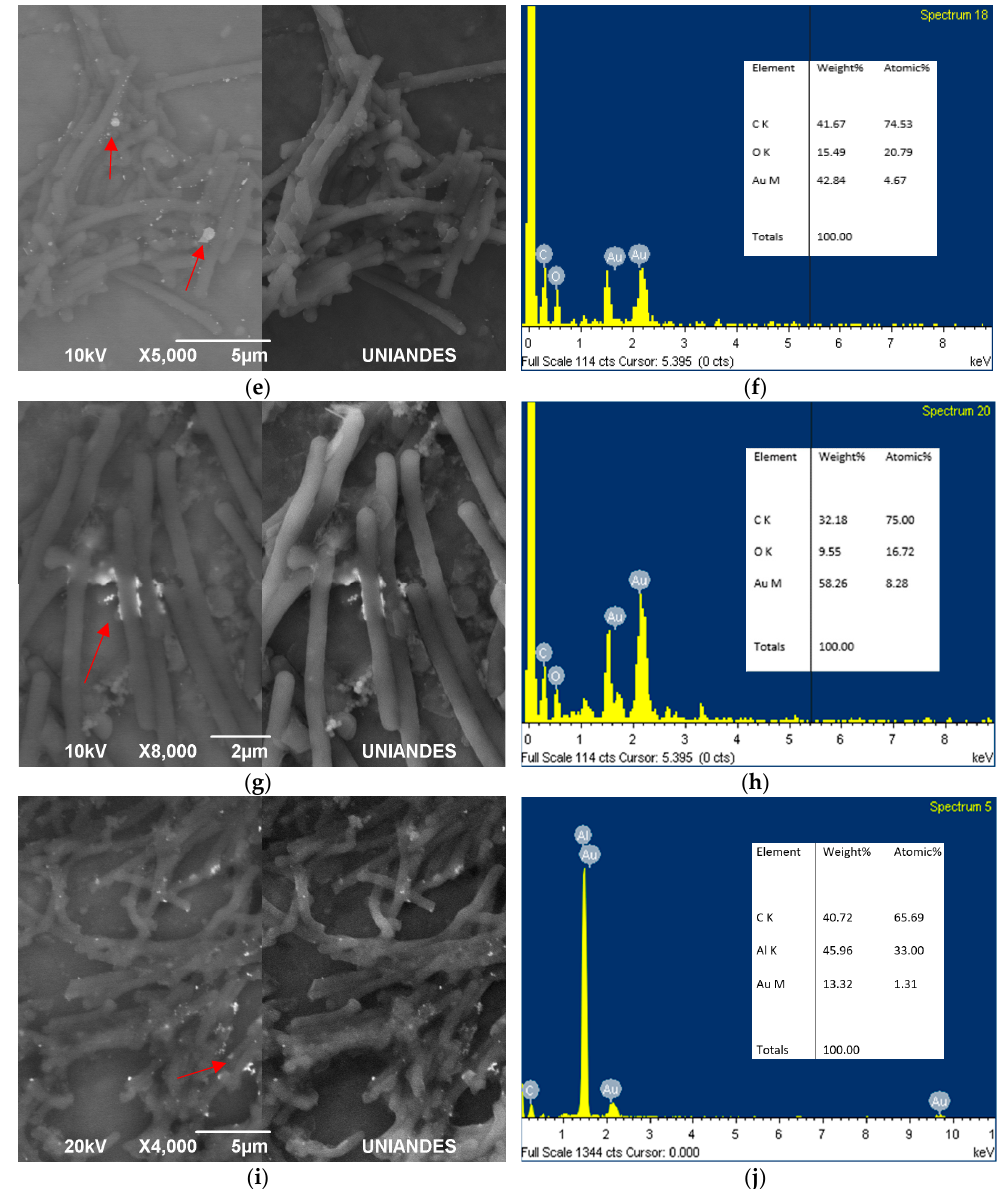
Figure 4. SEM images with SEI (secondary electrons) and BEC (Backscattered electrons) for bioassays with living cells of Lysinibacillus sphaericus ( a ) CBAM5 and ( b ) energy-dispersive X-ray spectroscopy (EDS) analysis; ( c ) mix of CIMIC collection strains (CBAM5, OT4b.31, III(3)7) with ( d ) EDS analysis. Additionally, L. sphaericus ( e ) strain MCB1 alone with its respective ( f ) EDS analysis and ( g ) MCB2